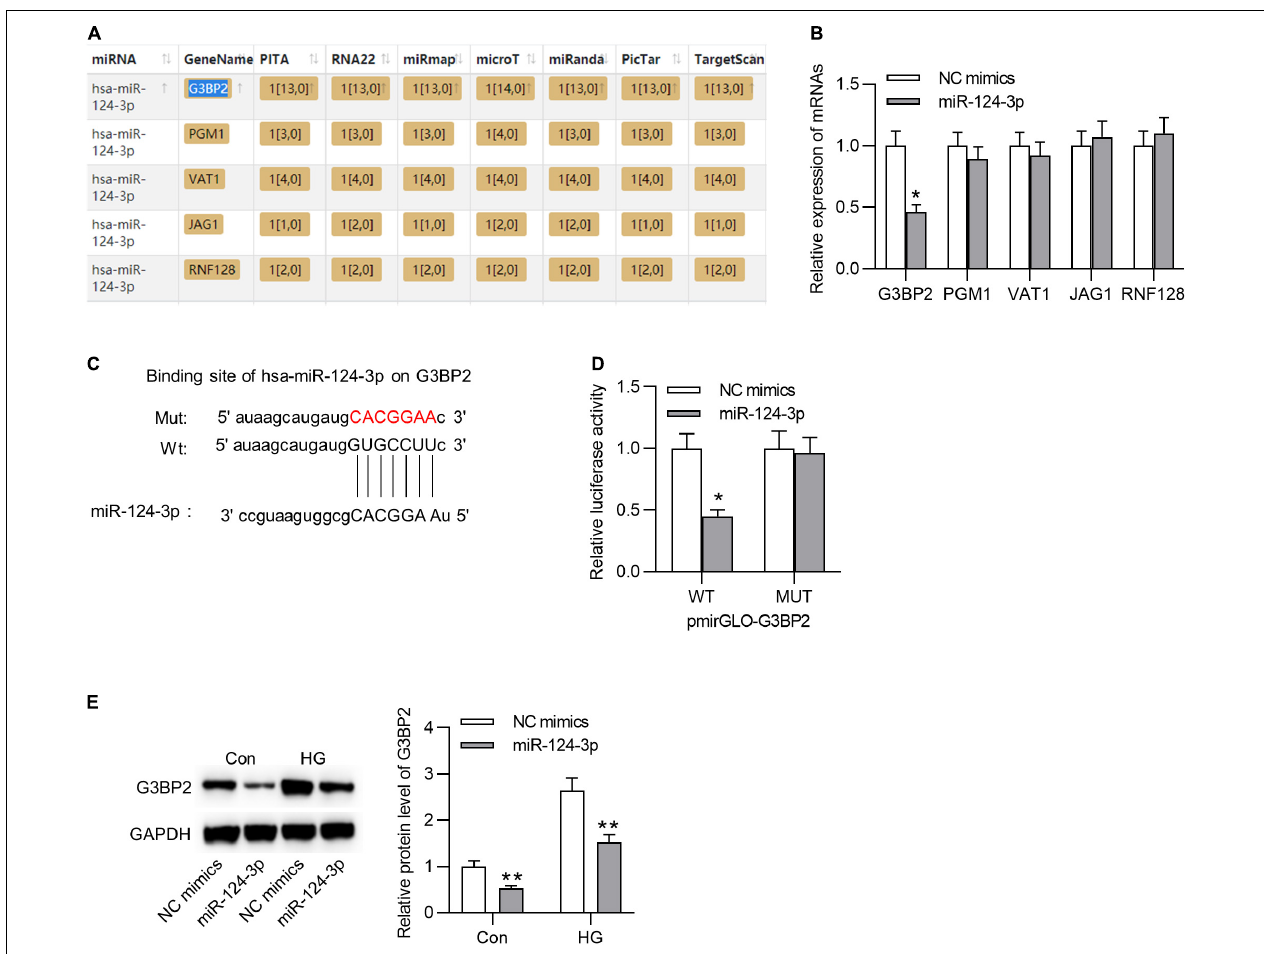
FIGURE 3 | MiR-124-3p interacted with G3BP2 to promote its degradation. (A) The mRNAs possessing binding site with miR-124-3p were predicted from starBase. (B) The effect of transfection of miR-124-3p mimics for 24 h on the expressions of the 5 candidate mRNAs in HG (30 mM glucose)-stimulated HRMECs was detected with RT-qPCR analysis. (C) The binding site between miR-124-3p and G3BP2 3 (cid:48) UTR was predicted from starBase. (D) The HRMECs were co-transfected with miR-124-3p mimics (or NC mimics) and pmirGLO-G3BP2-Wt (or pmirGLO-G3BP2-Mut) vectors for 48 h, and then relative luciferase activities were detected. (E) The effect of transfection of miR-124-3p mimics for 24 h on the protein level of G3BP2 in NG (5 mM glucose) or HG (30 mM glucose)-stimulated HRMECs was detected by western blot analysis. * P < 0.05, ** P <